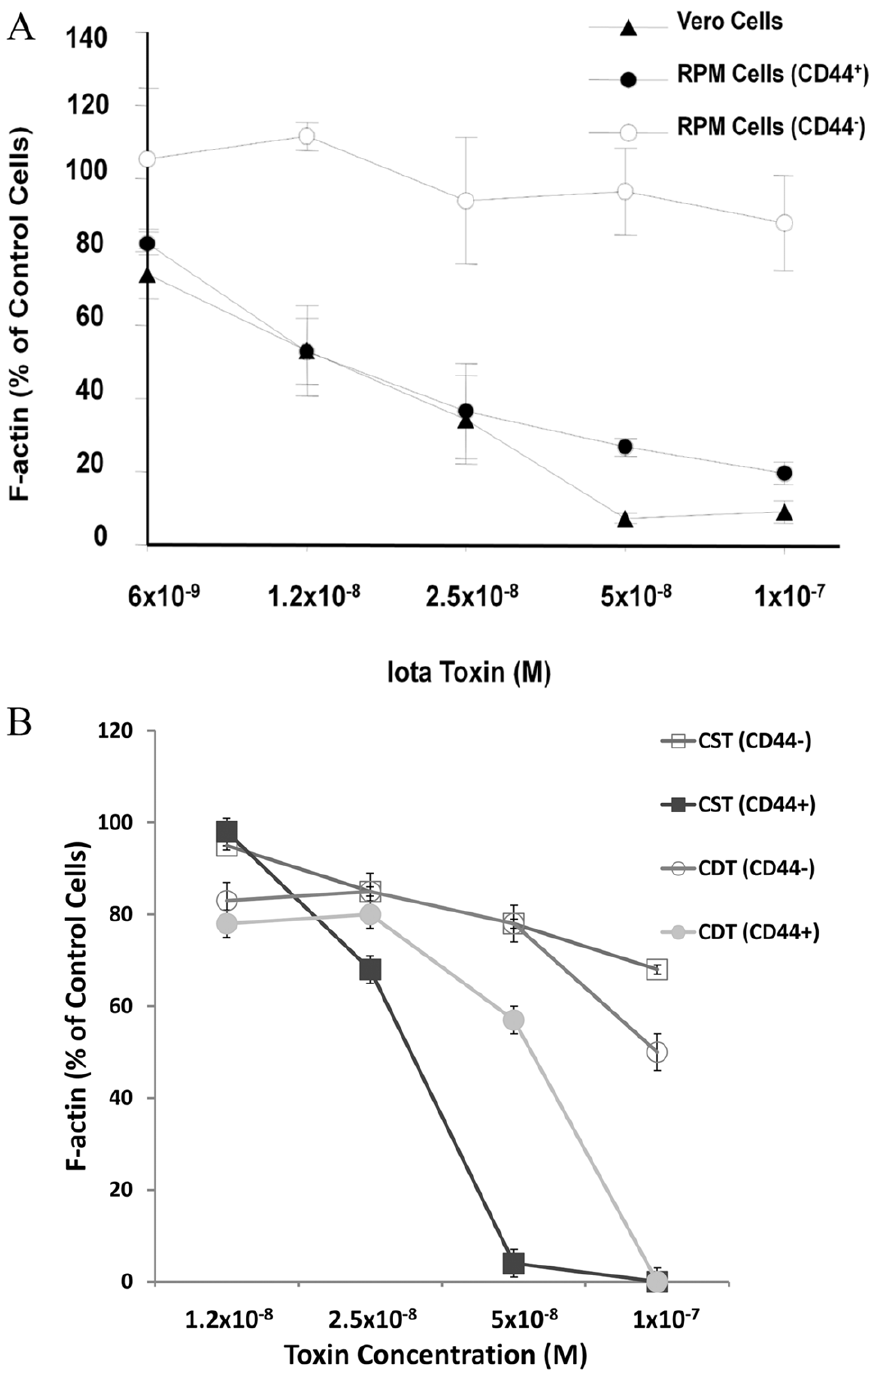
Figure 2. CD44 2 cells are resistant to iota and iota-like toxins versus CD44 + cells. ( A ) Dose-response of iota toxin on cells with controls consisting of cells in media only. The Y-axis represents the ‘‘% control’’ of F-actin content (Alexa-488 phalloidin stained after 5 h) in intoxicated cells versus controls in media only. ( B ) Like iota toxin, CD44 + RPM cells are also susceptible to C. difficile (CDT) and C. spiroforme (CST) binary toxins. Each assay was done in duplicate and values represent mean + / 2 standard deviation from three separate